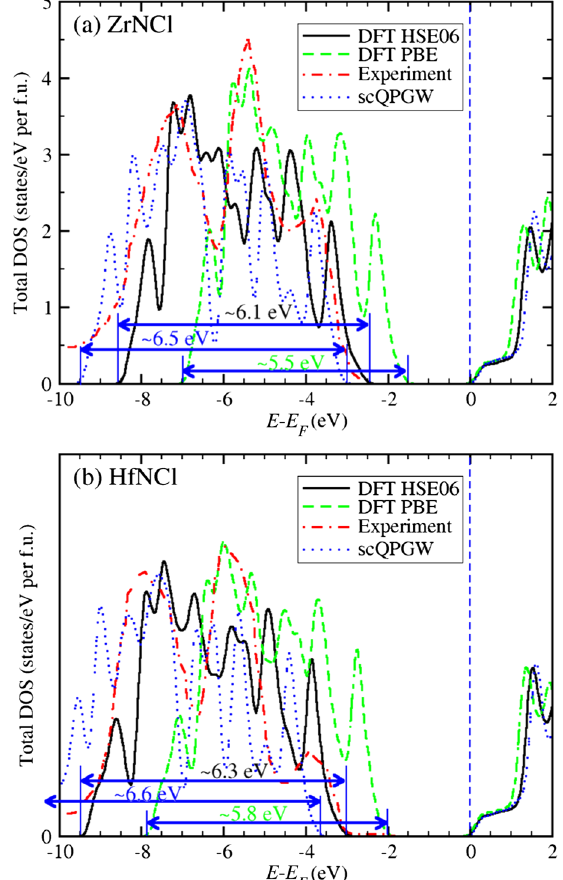
FIG. 6. Density of states of (a) ZrNCl and (b) HfNCl. The theoretical total DOS is calculated using the scQP GW method and the PBE functional and the HSE06 hybrid functional within DFT. The experimental data are the photoemission spectra taken from Ref. [75].